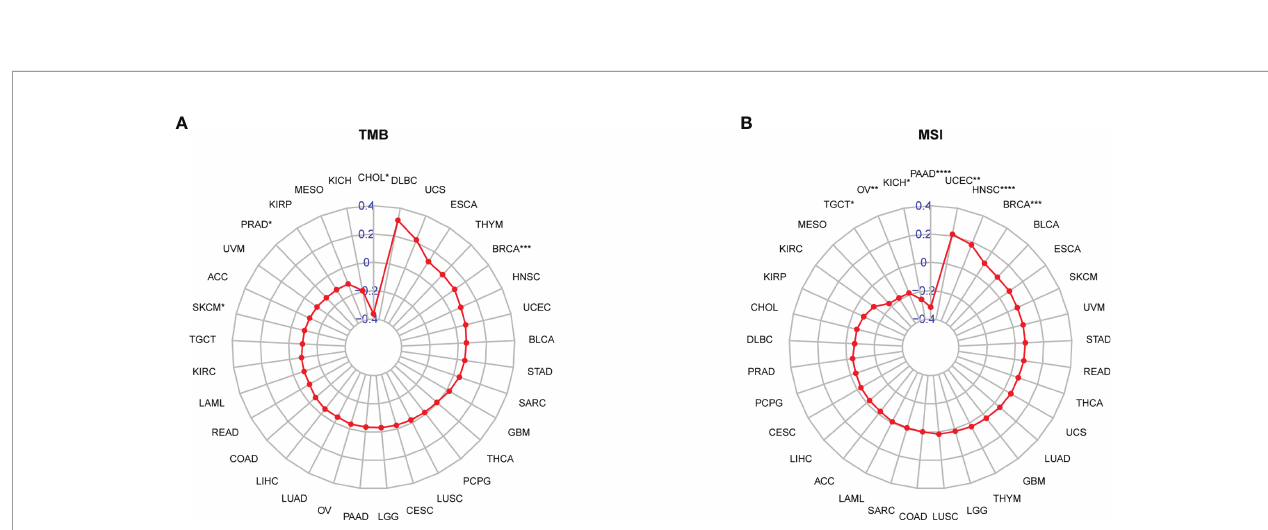
FIGURE 13 | Correlation between TRP score and TMB and MSI values. (A, B) Radar plot of the correlation between TRP score and (A) TMB or (B) MSI. * P < 0.05, ** P < 0.01, *** P < 0.001, **** P <